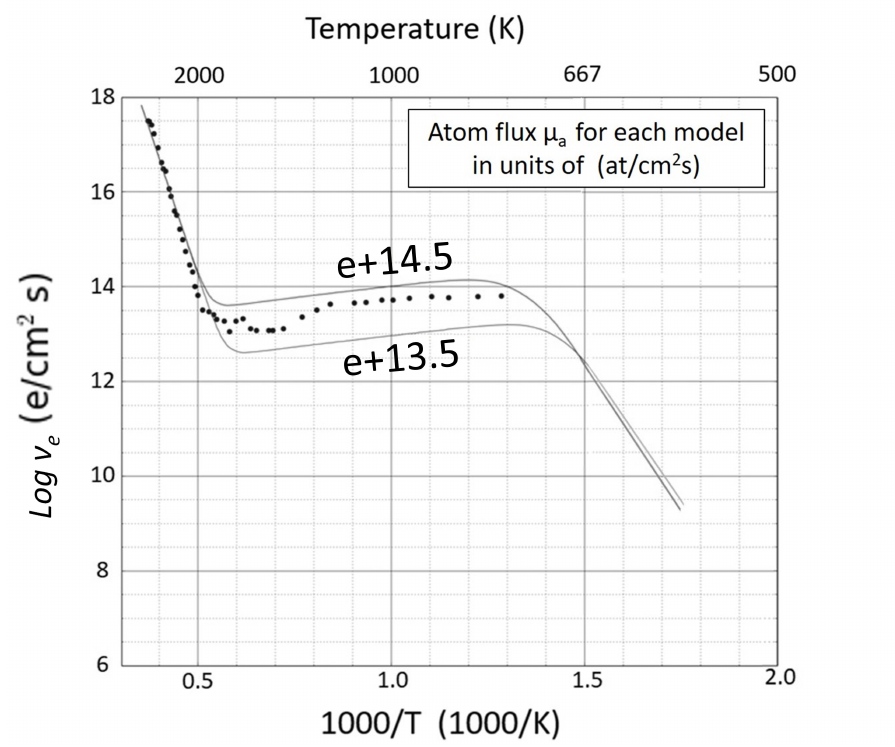
Figure 6. One measurement of the thermionic emission curve as a function of temperature. This measurement is fit to a solid curve corresponding to 10 14.23 at/cm 2 s, an atom flux which can be converted to 1.30 × 10 − 4 Pa. The y -axis is in Log scale and each curve is labeled with the atomic flux, where e+14 ≡ 1 × 10 14 (at/cm 2